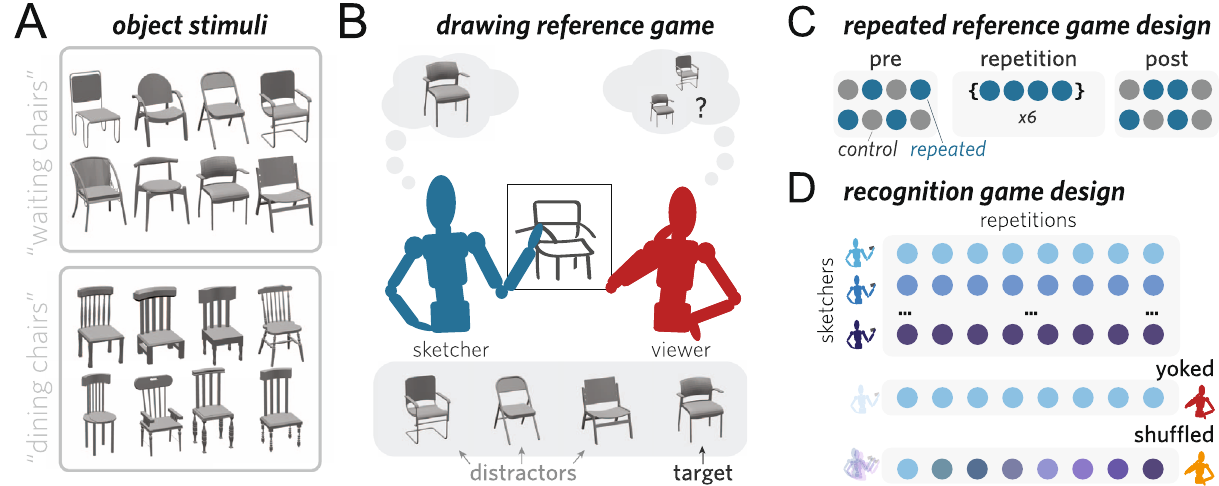
Fig.2|Experimentaldesign.A Twoobjectcollectionswereused,eachcontaining eightsimilarobjects.Imagesofobjectswererenderedfrom3Dmeshmodelsinthe ShapeNet database and appear in this fi gure with permission. B Pairs of partici- pants performed a drawing-based reference game in which one participant (sketcher) was cued to draw the target object such that the other participant (viewer) could identify it in context. C Four objects were drawn repeatedly